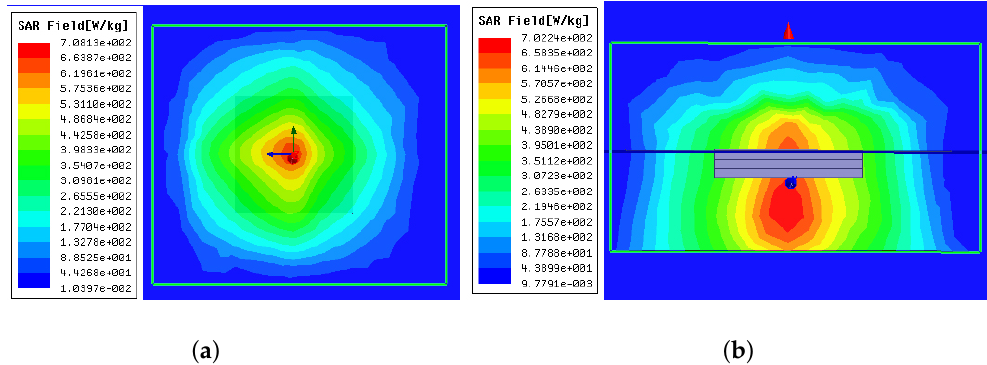
Figure 6. Simulated SAR distribution ( a ) in x-y plane above and the top layer of the antenna and ( b ) x-z